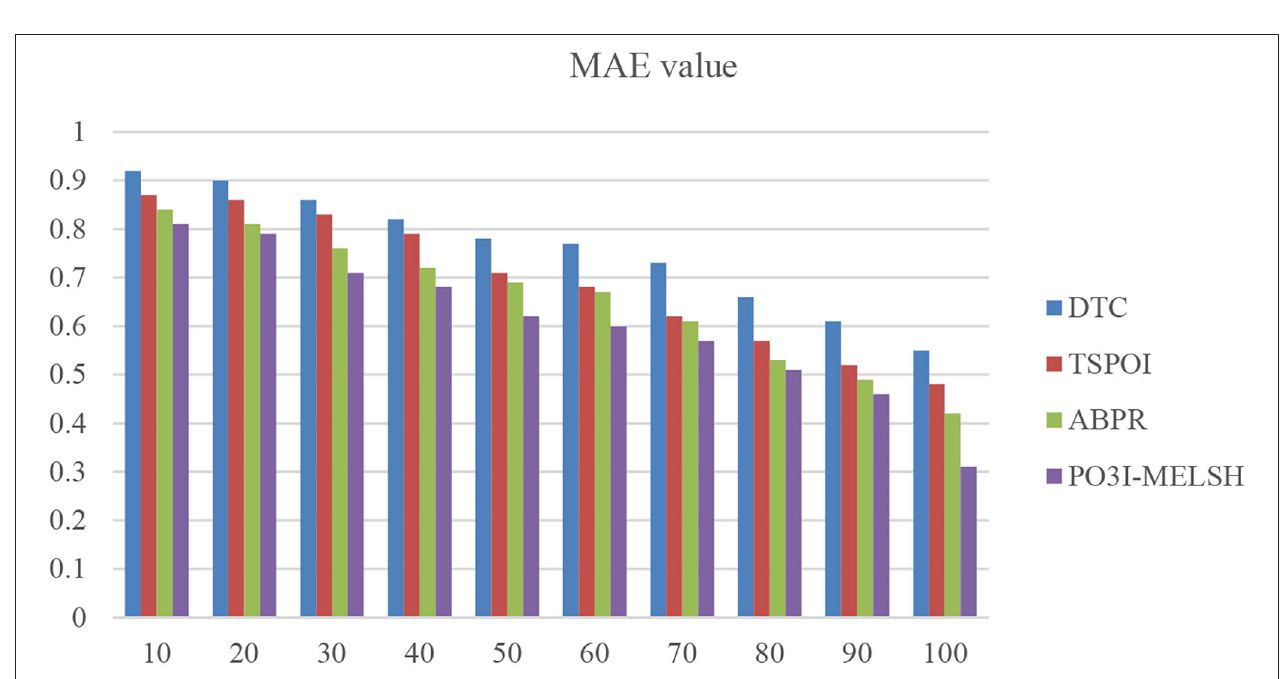
FIGURE 8 | MAE comparison with different